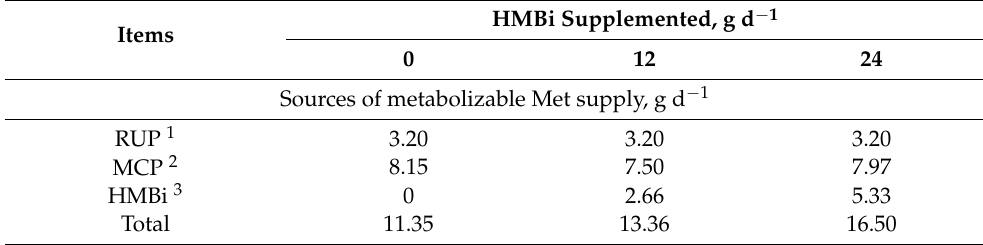
Table 2. Met requirement and supply of beef